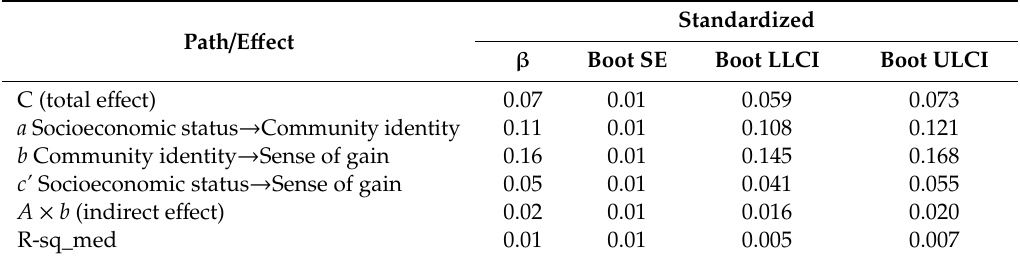
Table 3. Test of mediation e ff ects of community identity on the relationship of socioeconomic status to sense of gain: Bootstrap